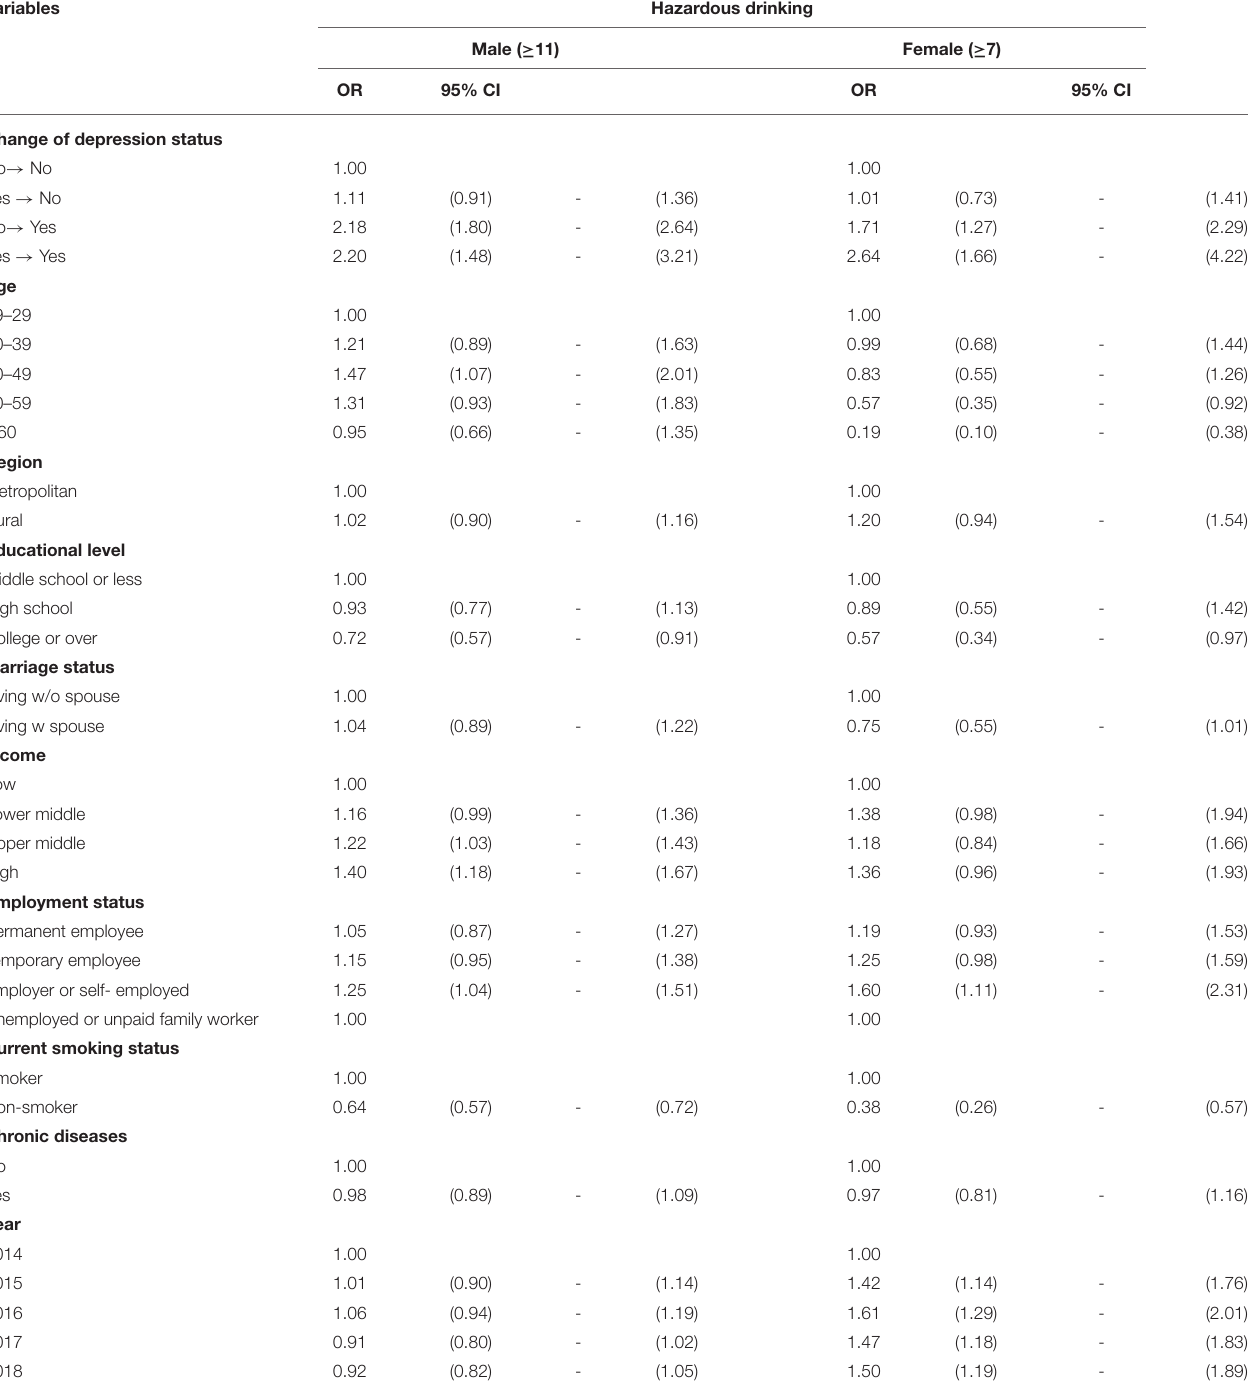
TABLE 2 | Results of the generalized estimating equation analysis of factors associated with Hazardous